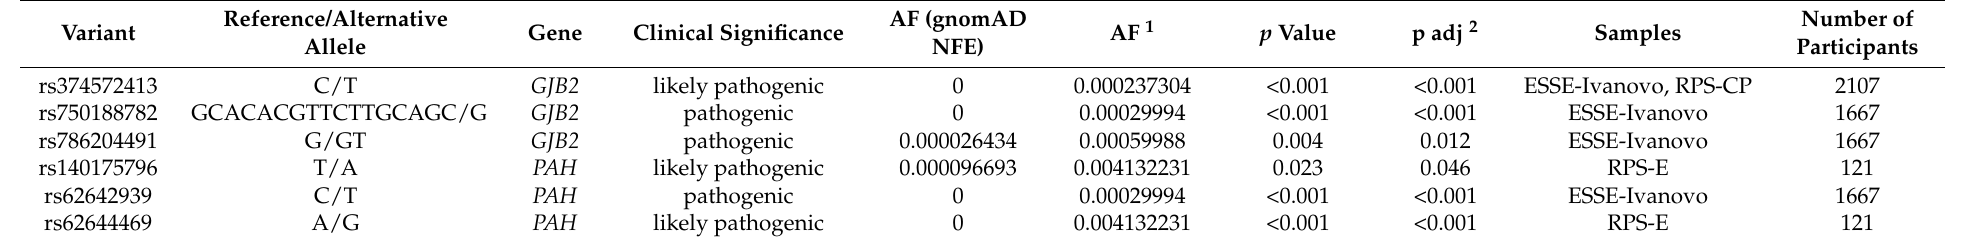
Table 5. Additional pathogenic and likely pathogenic variants in the adjacent sequenced regions detected in studied samples with significant differences in AF between studied samples and NFE